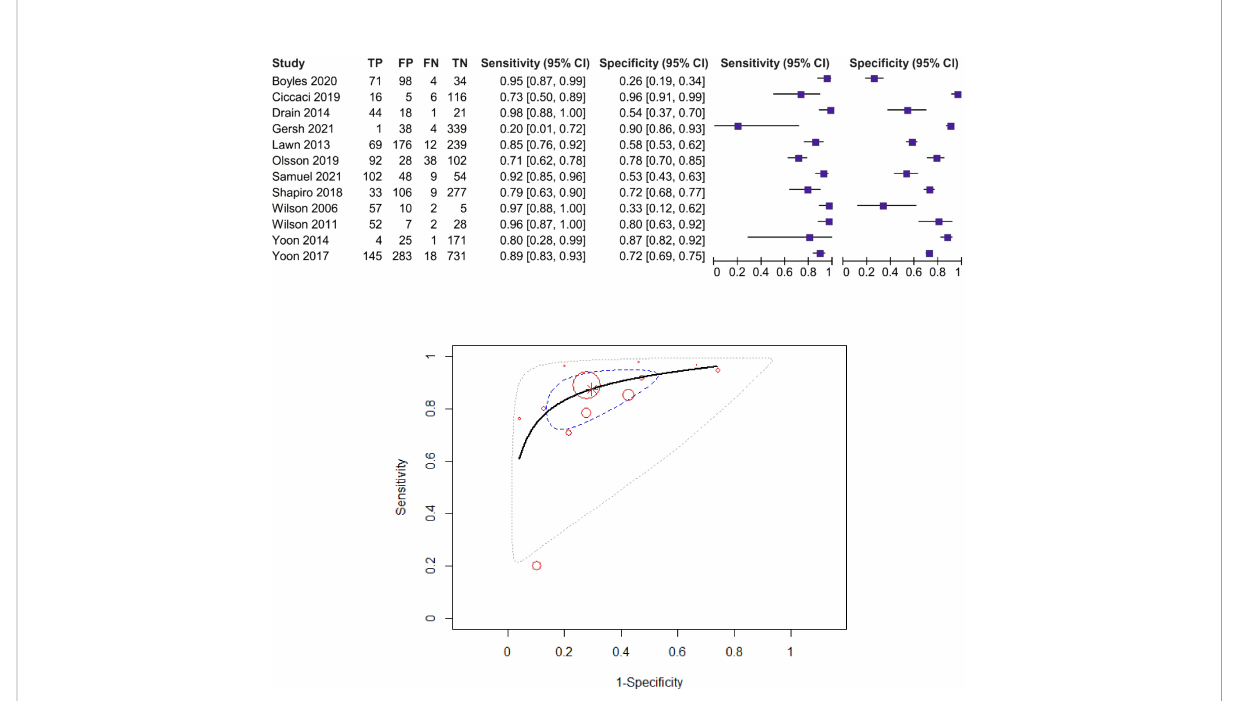
FIGURE 4 Forest plot and SROC curve (HIV patients, using the CRP threshold of 8 mg/L). The symbol * represents the pooled sensitivity and speci fi